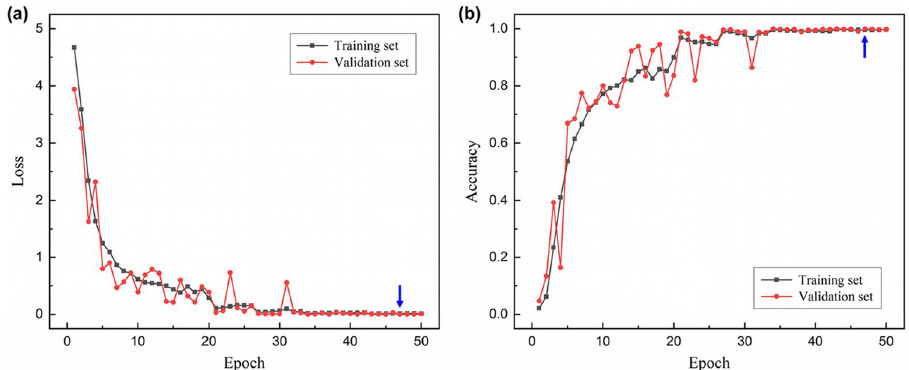
Figure 5. Training results of the designed CNN. ( a ) Loss and ( b ) accuracy curves for the training set and validation set. Blue arrows indicate the 47th epoch where the validation loss is minimum. Validation loss and validation accuracy were 6.46e−4 and 99.9% at the epoch.